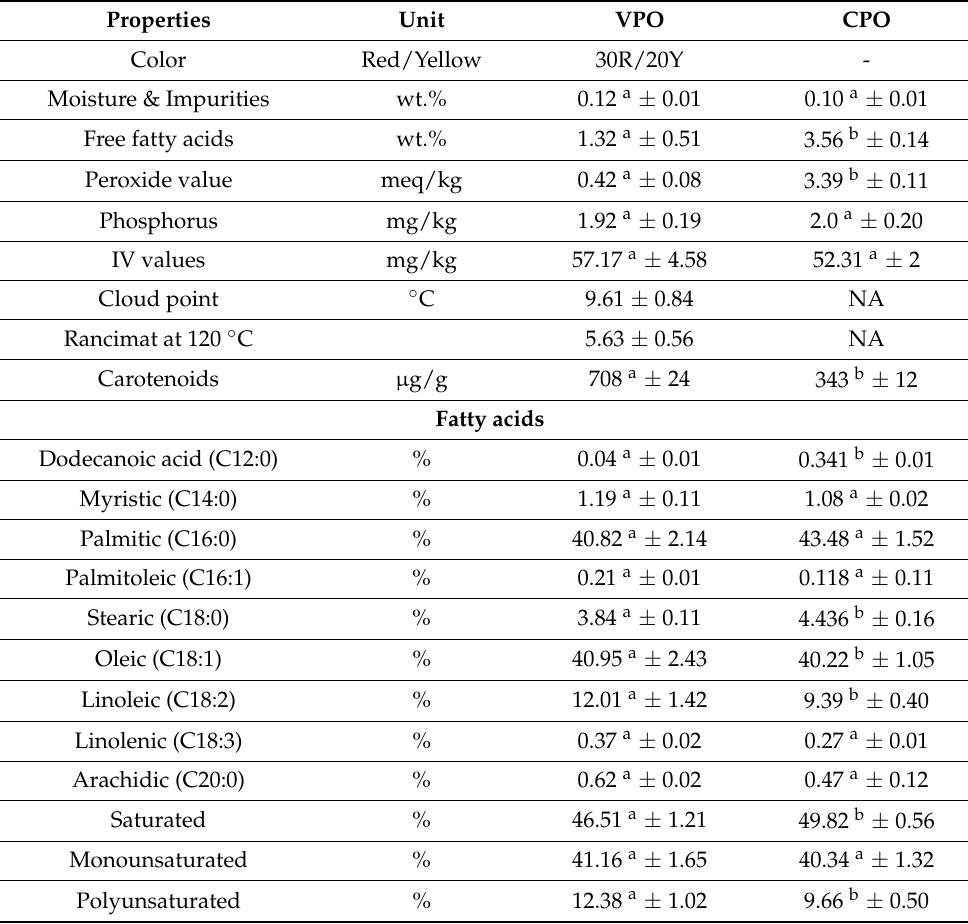
Table 6. Quality and fatty acid properties of virgin palm